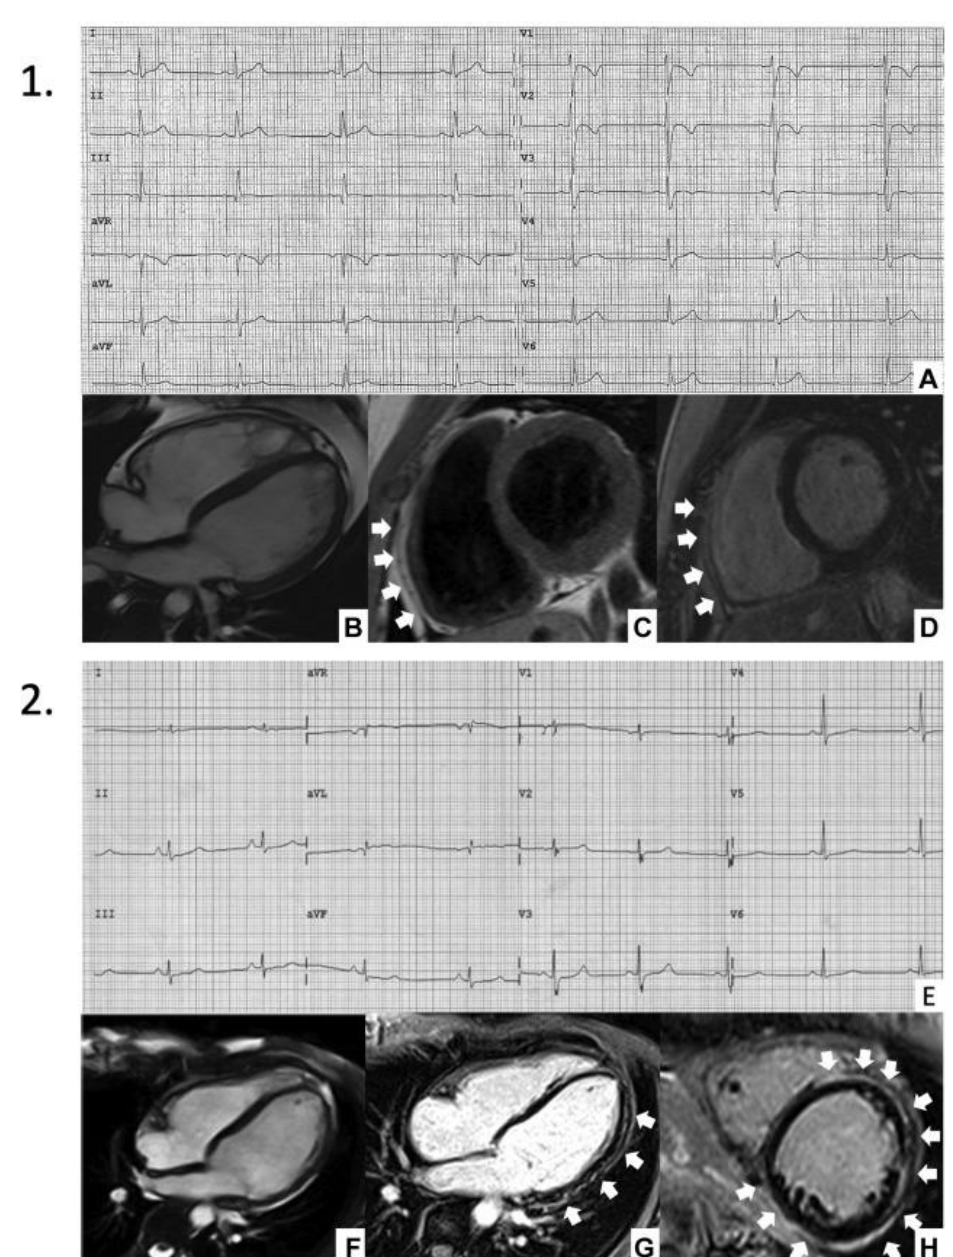
Figure 2. DSP cardiomyopathy. In Panel 1 , ECG demonstrates the presence of TWI from leads V1–V3 ( A ) and CMR shows mild RV dilatation and moderate dysfunction with anterior and inferior wall akinesia in the mid-apical segments ( B ); in the same regions, fibrofatty infiltration ( white arrows) was present ( C , D ). In Panel 2 , ECG shows diffuse-low QRS voltages ( E ) and CMR demonstrates a mild LV dilatation with moderate systolic dysfunction ( F ). After gadolinium administration, circumferential LGE (white arrows) appeared ( G , H ). CMR = cardiac magnetic resonance; ECG = electrocardiography; LGE = late gadolinium enhancement; LV = left ventricle; RV = right ventricle; TWI = T-wave inversion. Adapted from Bariani et al. [18] with permission. The patient consented to the publication of this material.